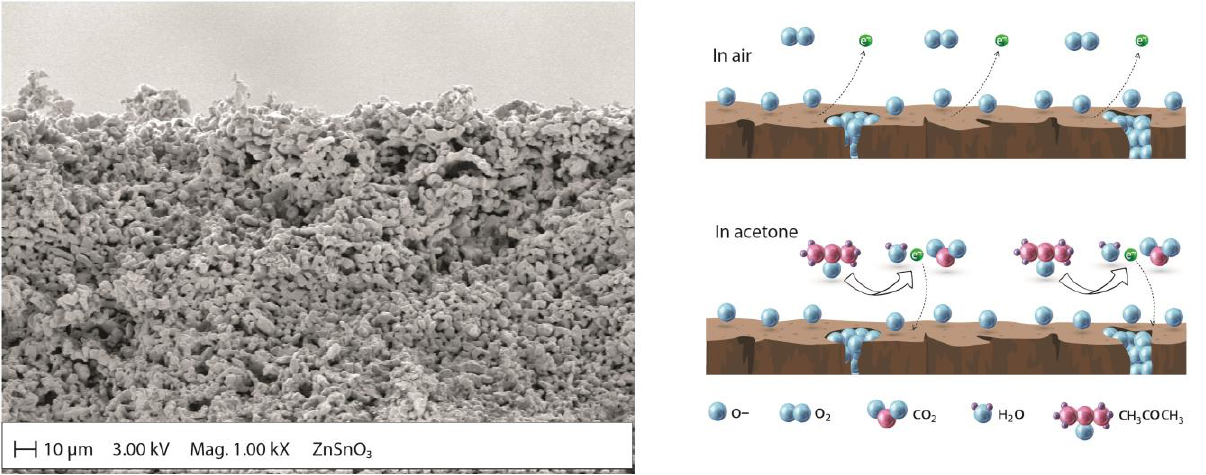
Figure 6. Scanning electron microscopy images and illustration of the gas-sensing mechanism of the ZnSnO 3 sensor (adapted from [44]).